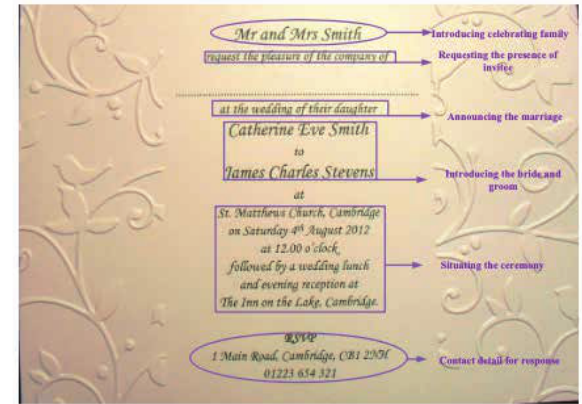
Figure 11: Invitation from